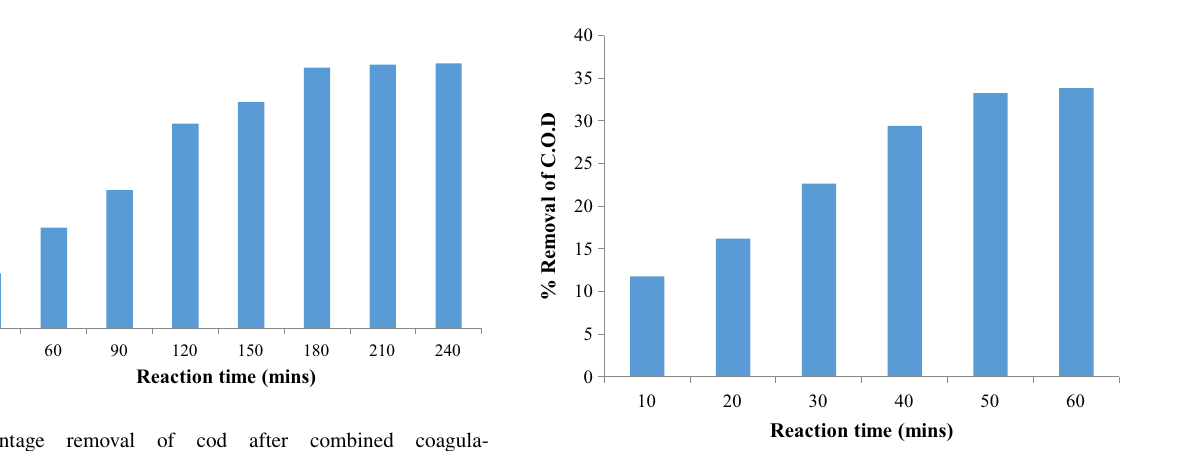
Fig. 6 Percentage removal of cod after combined coagula- tion and Fenton. Experimental conditions: FeSO 4 concentration (mg/L): 0.04 g, H 2 O 2 concentration: 1.4 ml, PH: 3, initial C.O.D: 52,800 mg/L, working volume: 250 ml